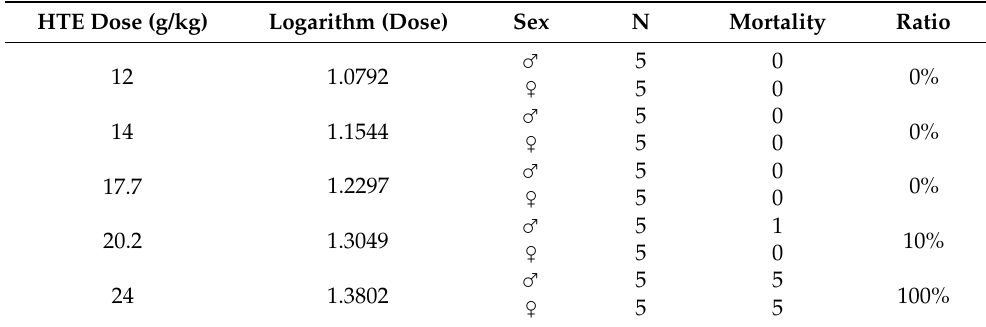
Table 1. Acute toxicity dose design and mortality on mice. n represents the number of mice. HTE Dose (g/kg) Logarithm (Dose) Sex N Mortality Ratio 12